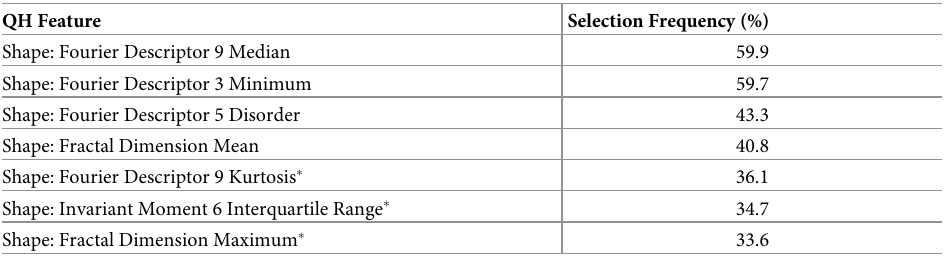
Table 5. Selected QH features. (cid:3) Features significantly correlated on the independent validation